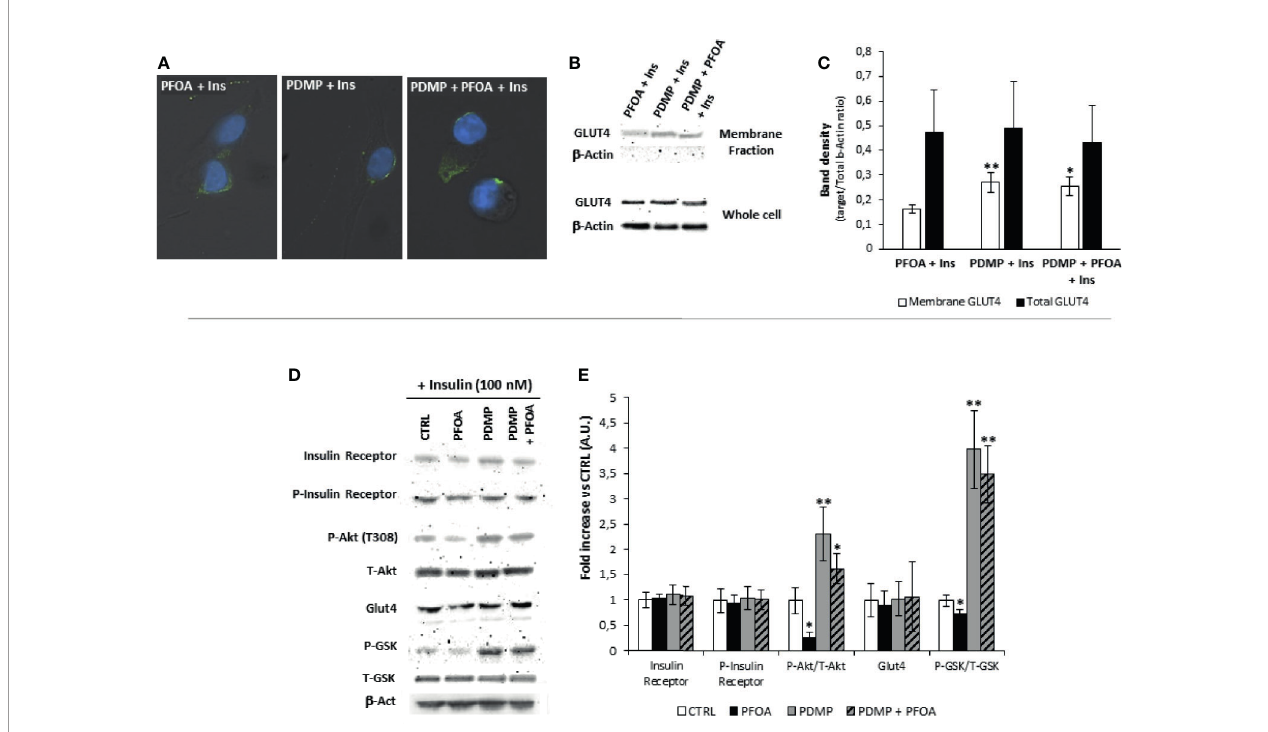
FIGURE 5 | (A) Representative images of immuno fl uorescence assay for Glut-4 glucose transporter (green) in HepG2 cells stimulated with 100 nm Insulin, with or without previous exposure to PFOA at the concentration of 1000 ng/mL, and eventually treated for 96 hours with (±)-threo-1-Phenyl-2-decanoylamino-3-morpholino- 1-propanol hydrochloride (PDMP) 20 ng/mL. Cells were counterstained with DAPI (blue) and merged with bright- fi eld images. Pictures are representative of three independent experiments. (B) Representative images of Western Blot analysis for Glut-4 protein expression in HepG2 cells at basal (CTRL) and stimulated with 100 nm Insulin with or without previous exposure to PFOA at the concentration of 1000 ng/mL, in the whole cell extract and after membrane protein fractionation. b -Actin in the whole cell extract was used as housekeeping. The histogram in (C) reports the target band density/total b -Actin density ratio for Glut-4 in the membrane fraction and whole cell extract. Data represent the mean value of three independent experiments. Signi fi cance: *P < 0.05 vs CTRL. (D) Western blot analysis of Insulin Receptor signaling pathway in HepG2 cells stimulated with 100 nm Insulin, after the exposure for 24 with PFOA at the concentration of 1000 ng/mL and eventually treated for 96 hours with PDMP. b -Actin served as housekeeping. The histogram plot in (E) shows the corresponding results of band density analysis. Data were normalized on the corresponding b -Actin and reported as the fold increase compared to control condition, in which PFOA was omitted, representing the mean value of three independent experiments. Signi fi cance: *P < 0,05 and **P < 0,01 respectively vs corresponding control stimulated with